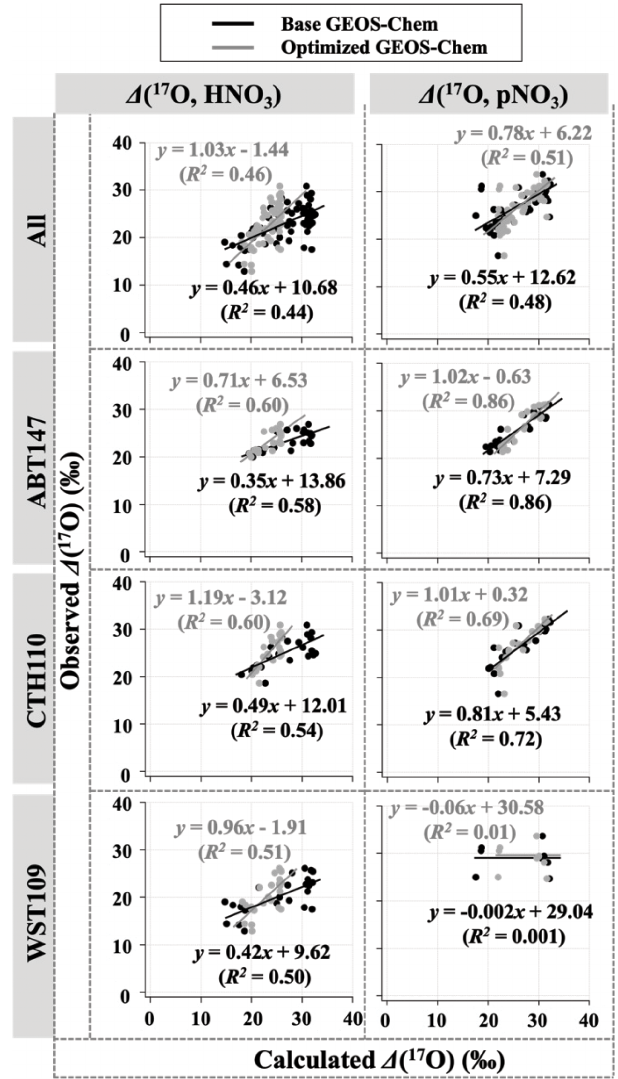
Figure 7. Correlation between observed and calculated (cid:49) ( 17 O) for HNO 3 and pNO 3 using base GEOS-Chem (black) and optimized GEOS-Chem (gray) for each